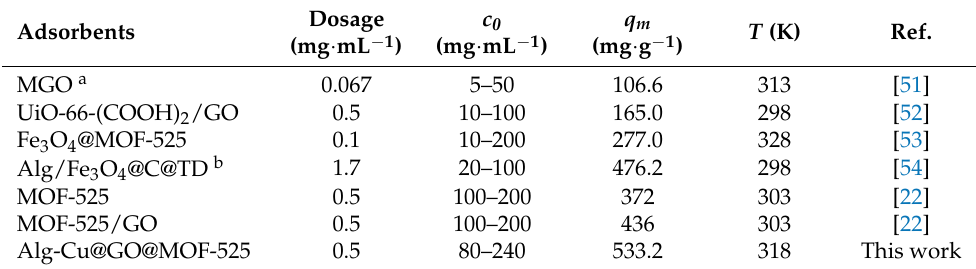
Table 3. Maximum adsorption capacity of different